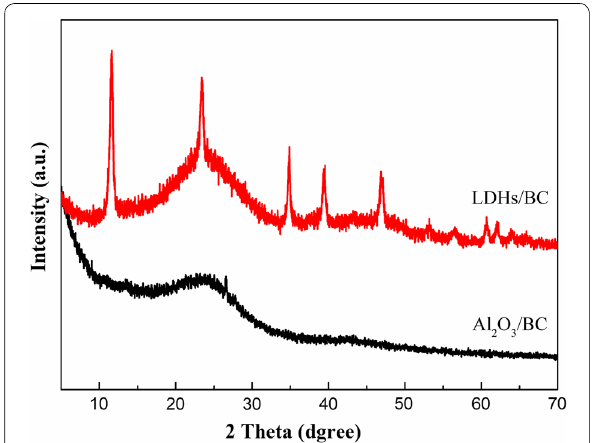
Fig. 1 XRD patterns of Al 2 O 3 /BCF and